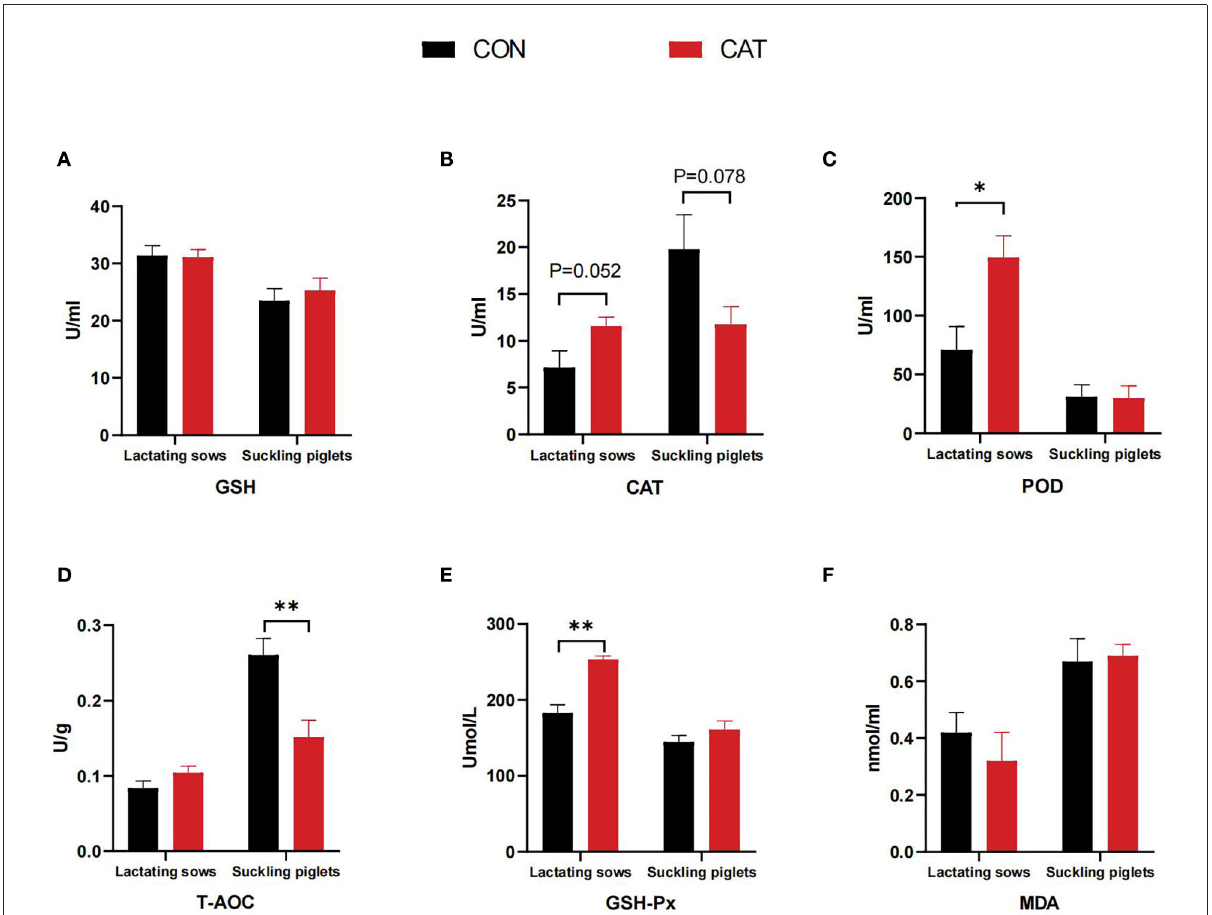
FIGURE2 (A–F) Serum antioxidant content of lactating sows and suckling piglets. Values are presented as mean ± SEM; * and **indicate a statistically significant difference by t -test at P < 0.05 and P < 0.01, respectively. GSH, glutathione; POD, peroxidase; CAT, catalase; GSH-Px, glutathione peroxidase; T-AOC, total antioxidant capacity; MDA,